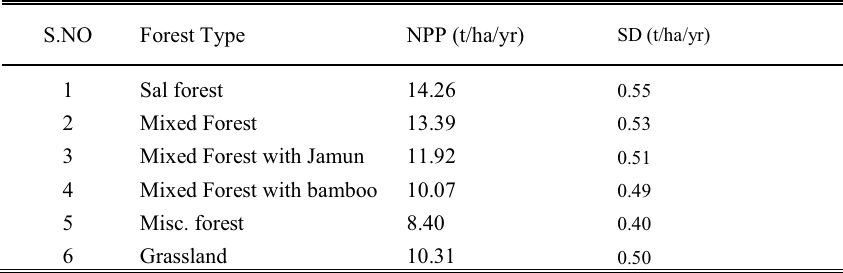
Table 3: The NPP of different forest types of Kanha National Park estimated using SPOT-Vegetation data It was observed from SPOT-VEGETATION analysis that NPP va- ried from 8.4 tC/ha/year (Dry deciduous) to 14.25 tC/ha/year (Moist deciduous) in KNP. The Singh and Singh, 1991 have re- ported 8.15 t/ha net above ground primary production (ANP) for dry deciduous forest ecosystem in India by field measurements.